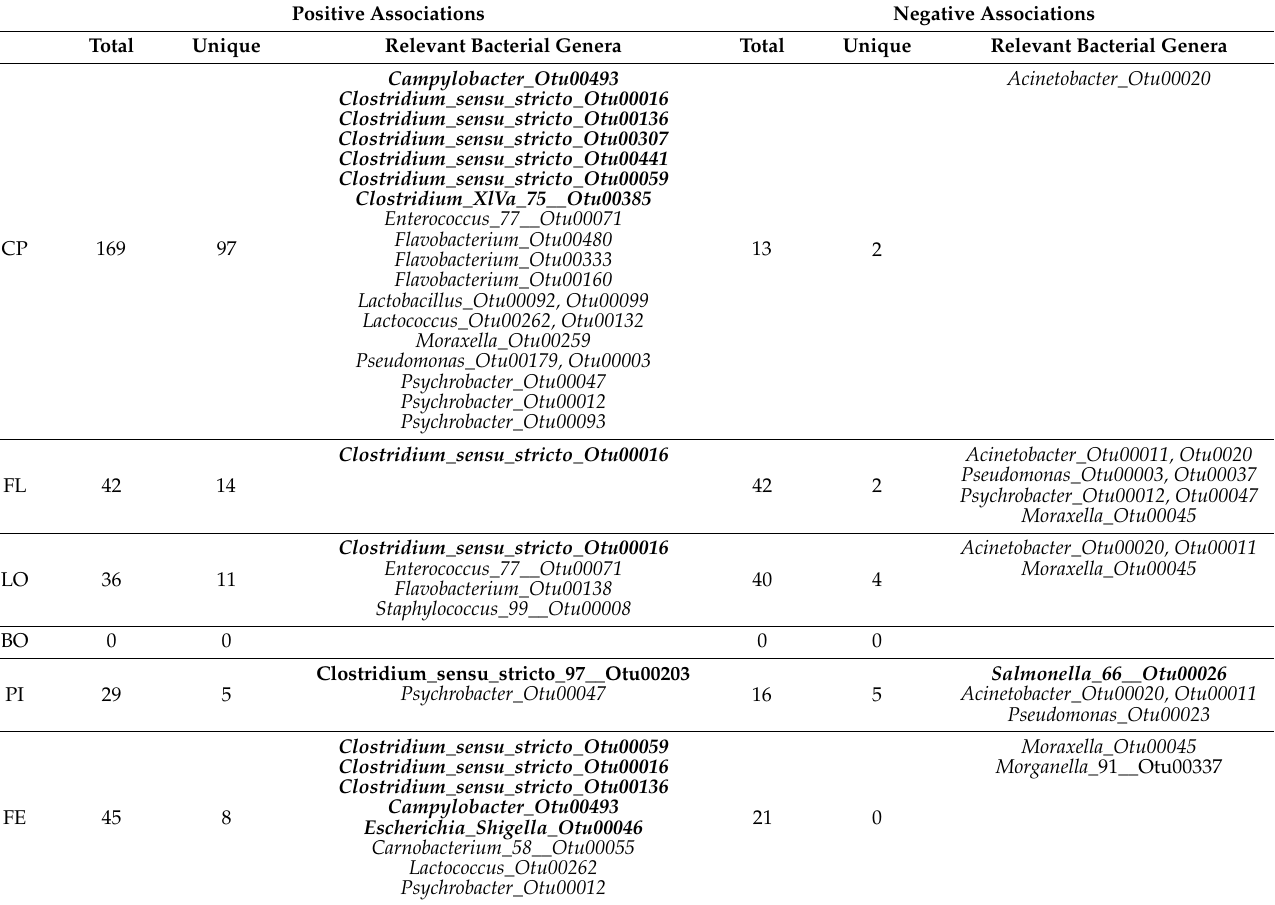
Table 6. Relevant bacteria (i.e., commonly known bacterial genera that can include potential spoilage species or potential foodborne pathogen species) extracted from the list of OTUs identified using the MaAsLin test and associated with the different production